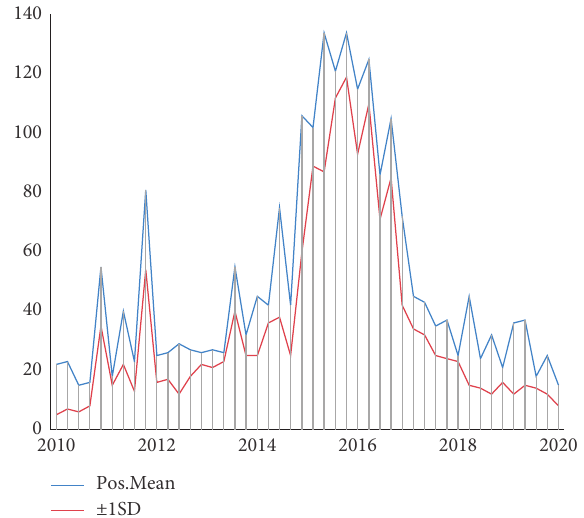
Figure 9: Time-varying features of stochastic price volatility for NFMM commodities.